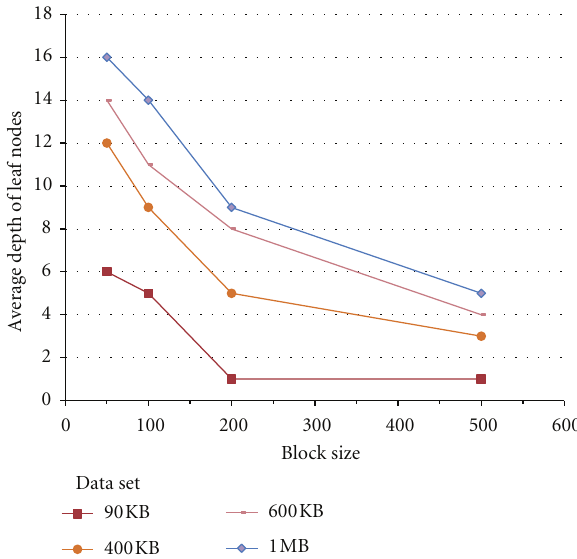
Figure 6: PHT structural properties: average depth of leaf nodes against block size for increasing data sets.